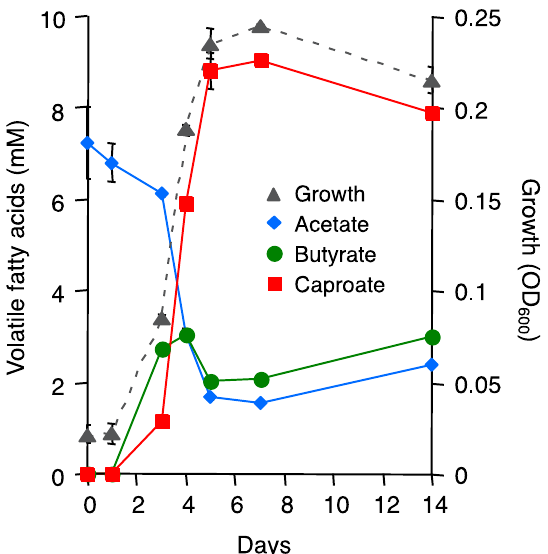
Figure 3. Growth and volatile fatty acid production by Clostridium sp. strain E801. The strain was grown anaerobically in the minimal medium containing ethanol and acetate. Symbols represent the mean values obtained for triplicate determinations, and bars indicate standard deviations.